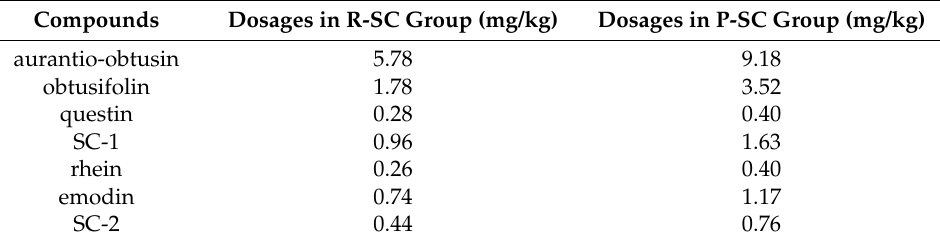
Table 6. The dosages of these analytes in the R-SC and P-SC group. Compounds Dosages in R-SC Group (mg/kg) Dosages in P-SC Group (mg/kg)